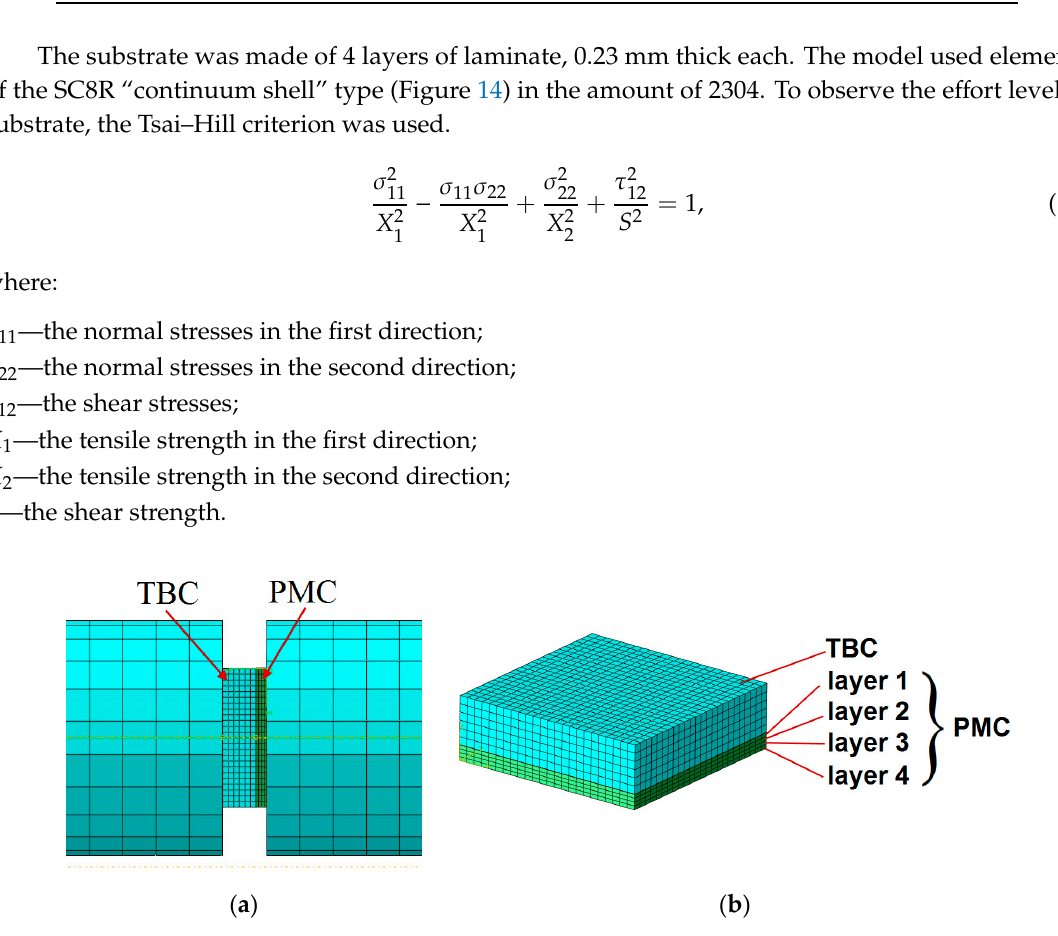
Figure 14. Mesh of finite elements. ( a ) sample between bars ( b ) layers of sample.